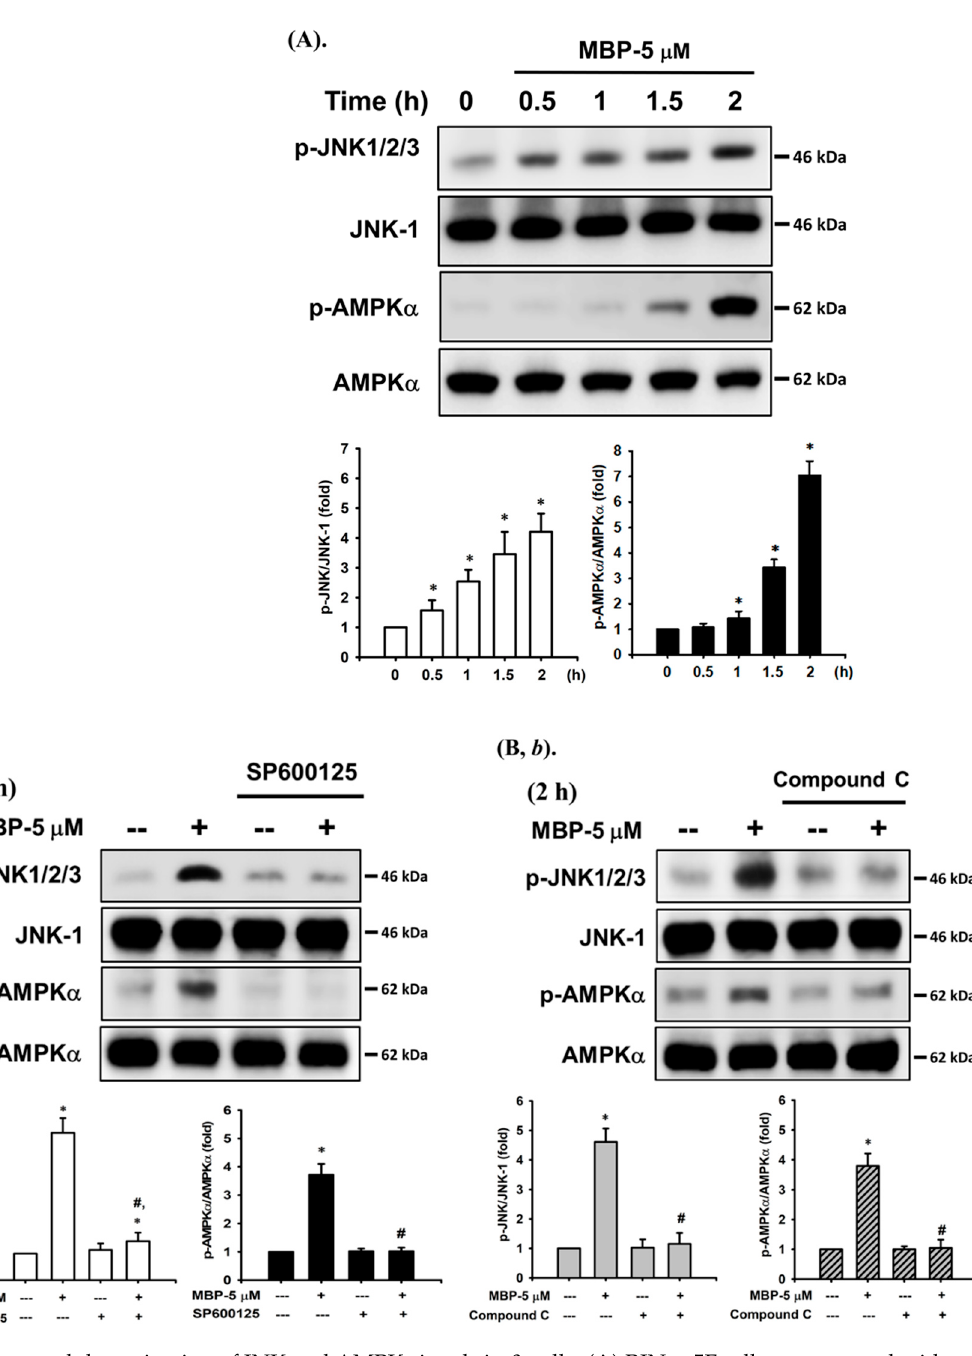
Figure 4. MBP caused the activation of JNK and AMPK signals in β -cells. ( A ) RIN-m5F cells were treated with or without MBP (5 µ M) for various time intervals (0.5–2 h). ( B ) RIN-m5F cells were treated with MBP (5 µ M) for 2 h in the presence or absence of the specific inhibitor of JNK1/2 (SP600125—10 µ M, ( B, a )) and AMPK α (compound C—10 µ M, ( B, b )). The protein expression of phosphorylated JNK1/2 and phosphorylated AMPK α was examined using Western blot analysis. The quantification was performed using densitometric analysis. Data are presented as the mean ± S.D. of four independent experiments assayed in triplicate. * p < 0.05 compared to vehicle control.